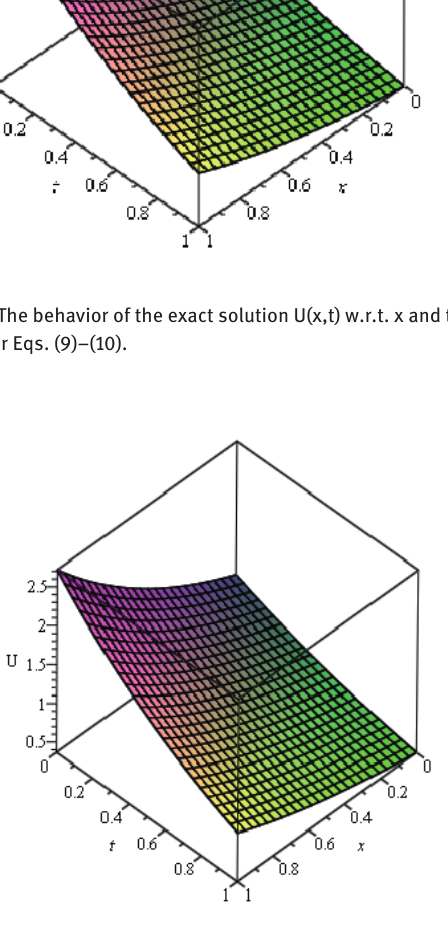
Fig. 2: The behavior of the approximate solution U(x,t) w.r.t. x and t, when α = 1 for Eqs. (9)–(10).